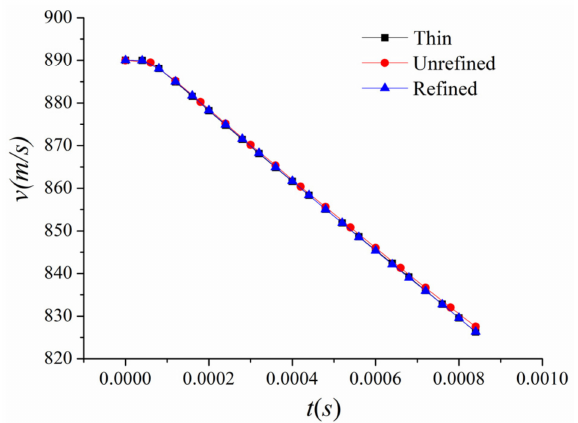
Figure 9. Velocity attenuation of refined and unrefined